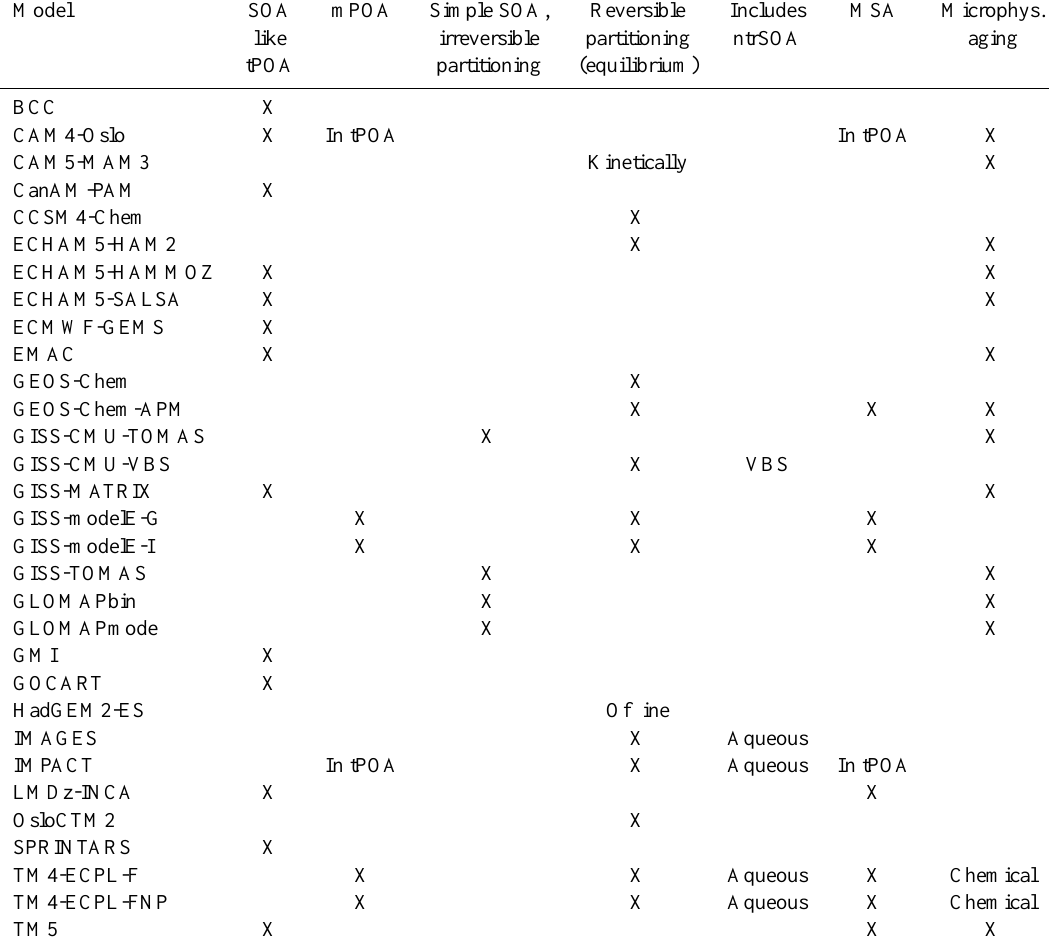
Table 2. Summary of organic aerosol processes taken into account by the models. Model Reversible